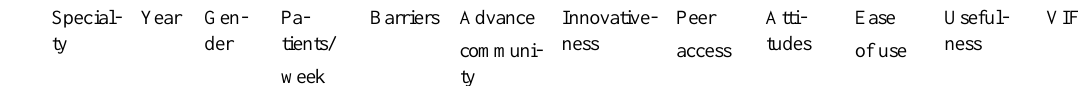
Table 2. Correlation between variables and variance inflation factors